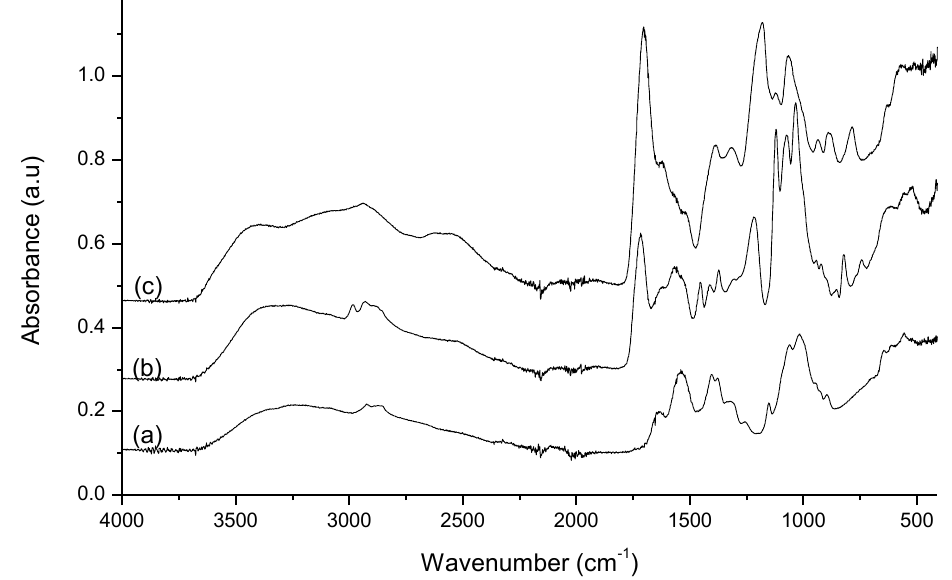
Figure 4. Normalized infrared spectra of chitosan films produced from a solution containing 1.5 wt. % of chitosan in solutions with 5 wt. % of ( a ) acetic acid, ( b ) lactic acid and ( c ) citric acid .